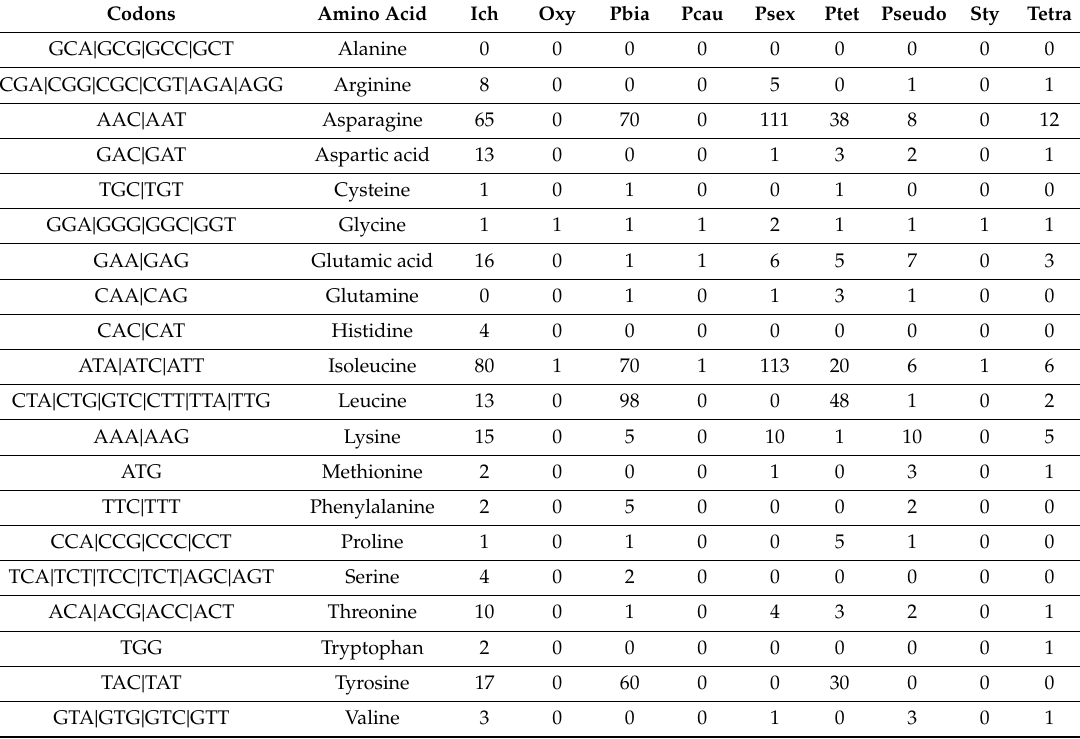
Table 3. Total counts of SSRs with codon repeats ( >= 10) in the nine ciliate